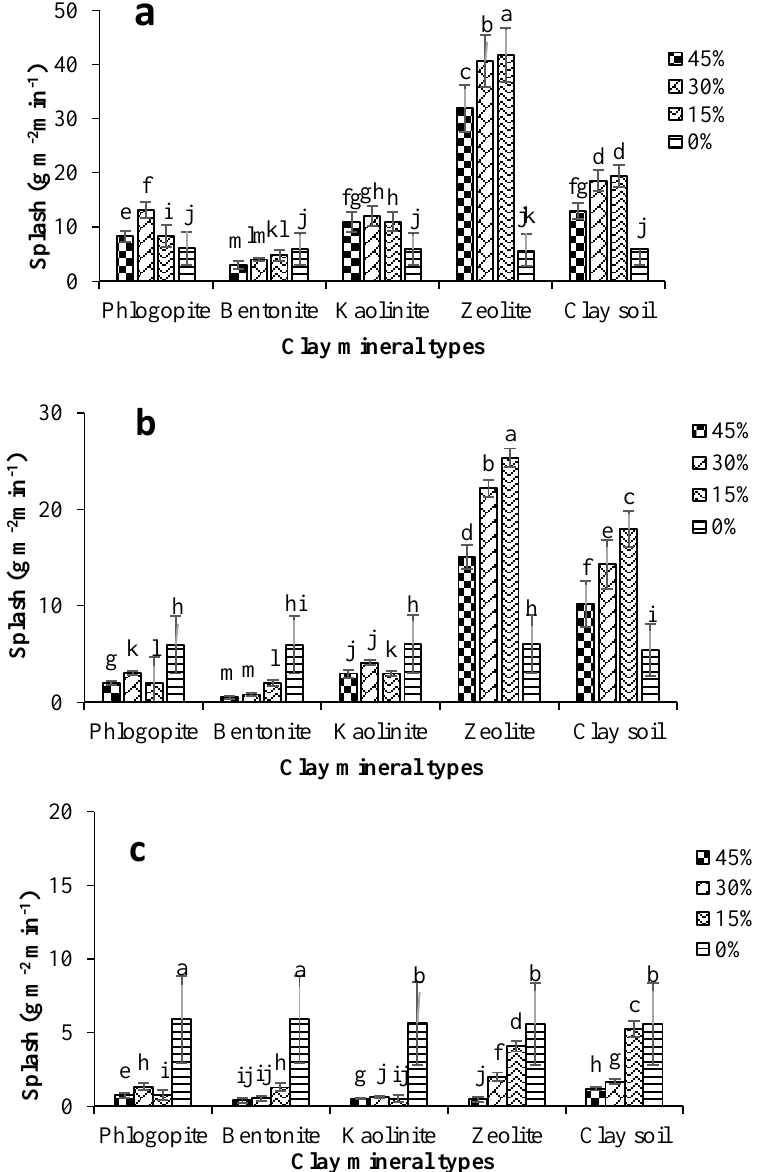
Figure 4. Comparisons of the mean interaction effects of clay type and percentage on the splash erosion (g cm − 2 ) of clay–sand mixtures and clay soil (LSD 0.05 ) without wetting and drying (W&D) cycles ( a ), after one cycle of W&D ( b ), and after two cycles of W&D ( c ). Different letters in the same column indicate significant differences ( p < 0.05) among land uses. For example, two columns labelled with the “b” letter are not statistically different, but columns labelled with the “a” and “b” letters are statistically different ( p < 0.05).